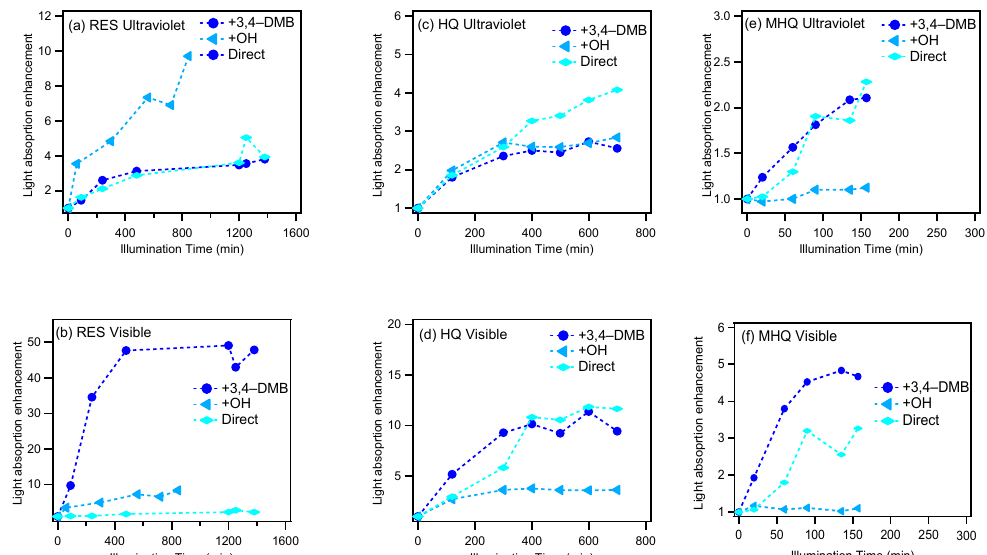
Figure 2. Variations of the light absorption enhancement (ratio of light absorption at the sampling time to that at the starting point) with illumination time in ultraviolet (200–380 nm) and visible light (380–600 nm) ranges, respectively.